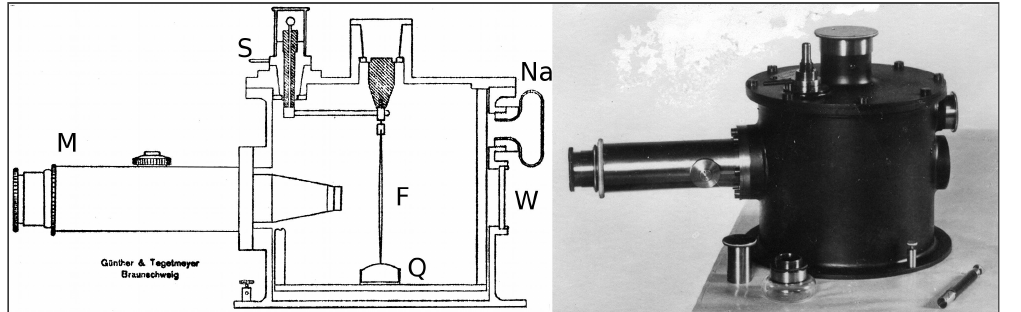
Figure 5. Wulf-type γ -ray electrometer manufactured by G&T after Hess’ suggestions. (W) is a window to illuminate the filaments (F), attached to a quartz string (Q). The filaments are observed with the microscope (M). The charge is applied through the electrode (S). A sodium container (Na) kept the inside